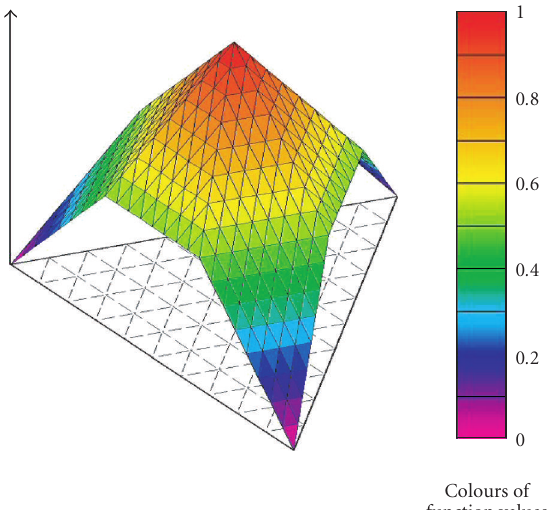
Figure 4.9. Normalised tent function F 3 ( γ ) for n = 3 defined on the simplex S 2 over triangular coordi- nates in the plane.